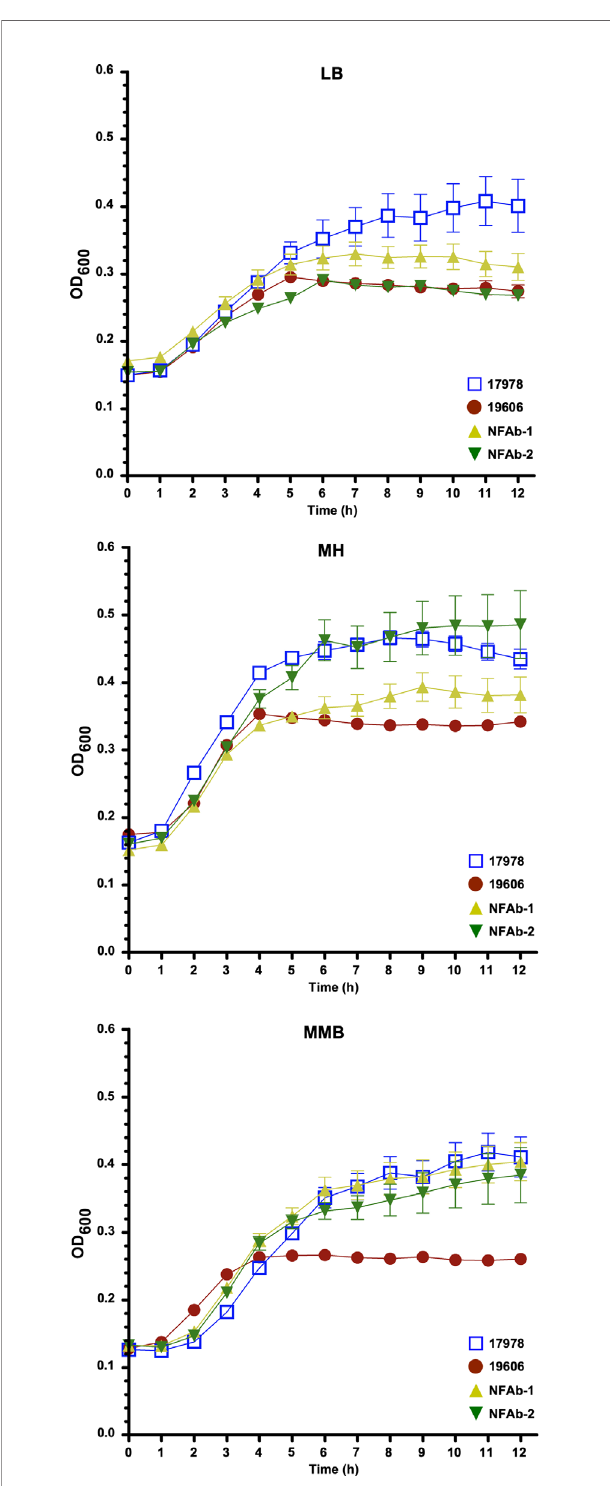
FIGURE 1 | Growth of A. baumannii strains in different media. Growth curves of the ATCC 19606 T , ATCC 17978, NFAb-1 and NFAb-2 strains cultured in LB, Mueller-Hinton (MH) or motility medium broth (MMB) at 37°C with shaking using three independent biological samples for each strain. The error bars represent the standard error of each data